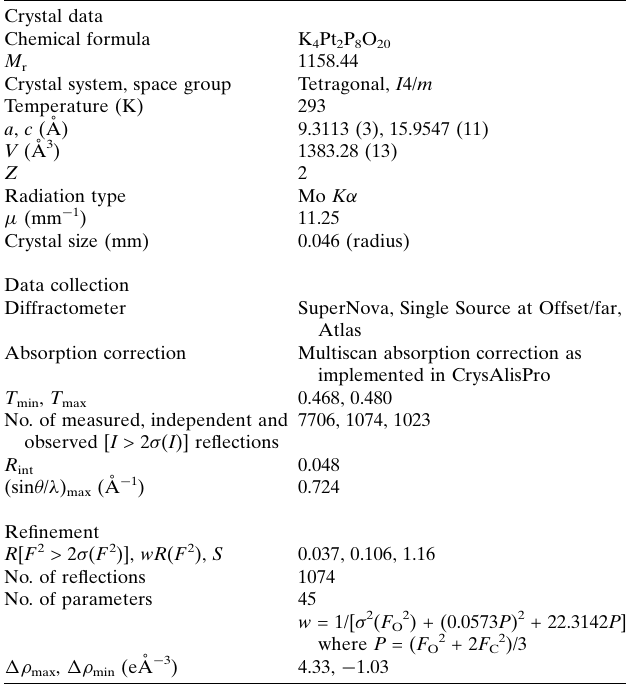
Table 1 Experimental details for K 4 [Pt 2 (P 2 O 5 H 2 ) 4 ] (cid:2) 2H 2 O. Hydrogen atoms and water molecules have been omitted.